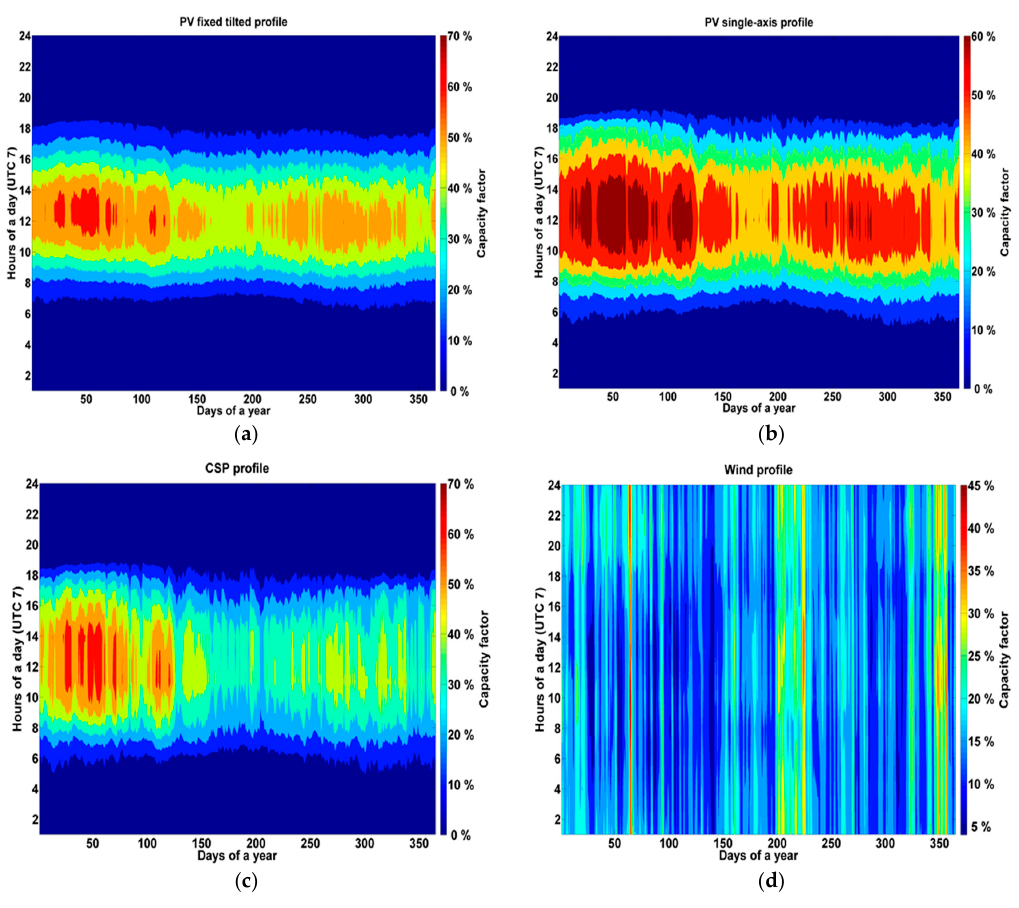
Figure 4. Aggregated feed-in profiles for: ( a ) optimally tilted PV; ( b ) single-axis tracking PV; ( c ) CSP solar field; and ( d ) wind power plant in Southeast Asia. Table 3. Average full load hours and levelized cost of electricity (LCOE) for single-axis tracking PV, optimally tilted PV, solar CSP and wind power plants in Southeast Asian regions. Pop.: population; mio.: million; Electr.: electricity and FLH: full load hours. Pop. Electr. Region [mio.